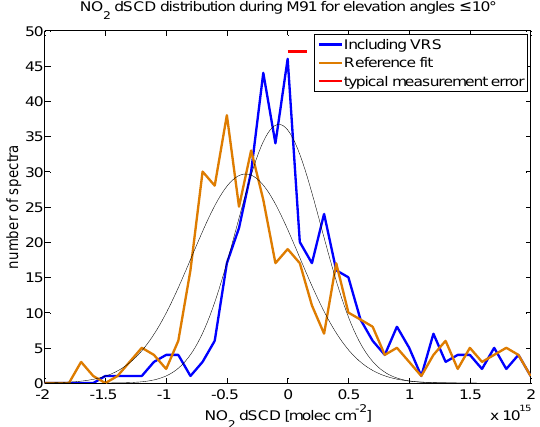
Figure 9. Histogram of NO 2 dSCDs in the wavelength range of 418–438nm illustrating the influence of VRS(N 2 / O 2 ) on the spec- tral retrieval of NO 2 . Twice the fit error is shown as a line on the top of the figure. The centre of the fitted gaussian curves is shifted from ( − 3 . 5 ± 0 . 4 ) × 10 14 moleccm − 2 to ( − 0 . 7 ± 0 . 3 ) × 10 14 moleccm − 2